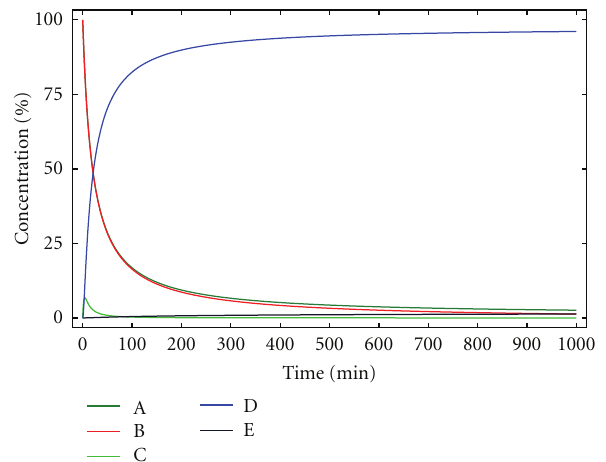
Figure 4: Concentration of the reactants, products, and reac- tion intermediates versus time for kinetic model 3. [A] 0 = [B] 0 = 0.005 M, k 1 = 10M − 1 min − 1 , k 2 = 0.5 min − 1 , and k 3 = 0.05M − 1 min − 1